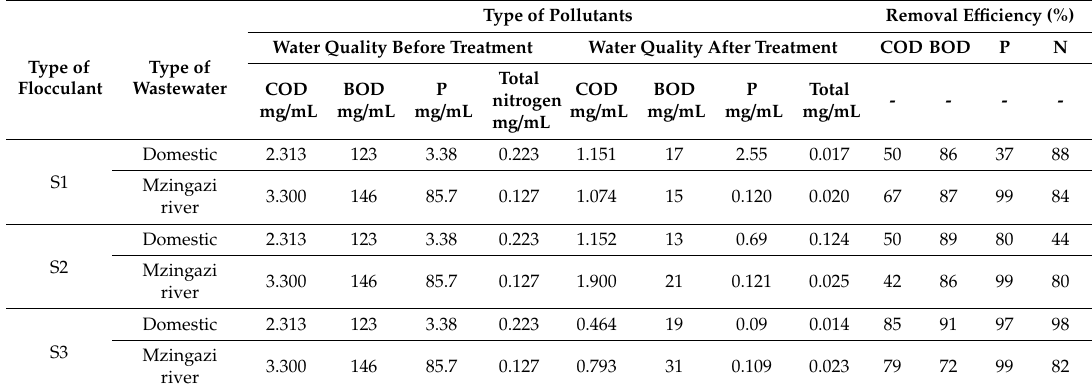
Table 3. Removal of pollutants in Vulindlela wastewater and Mzingazi River by nanoparticle samples S1, S2, and S3. Legend: COD, chemical oxygen demand; BOD, biological oxygen